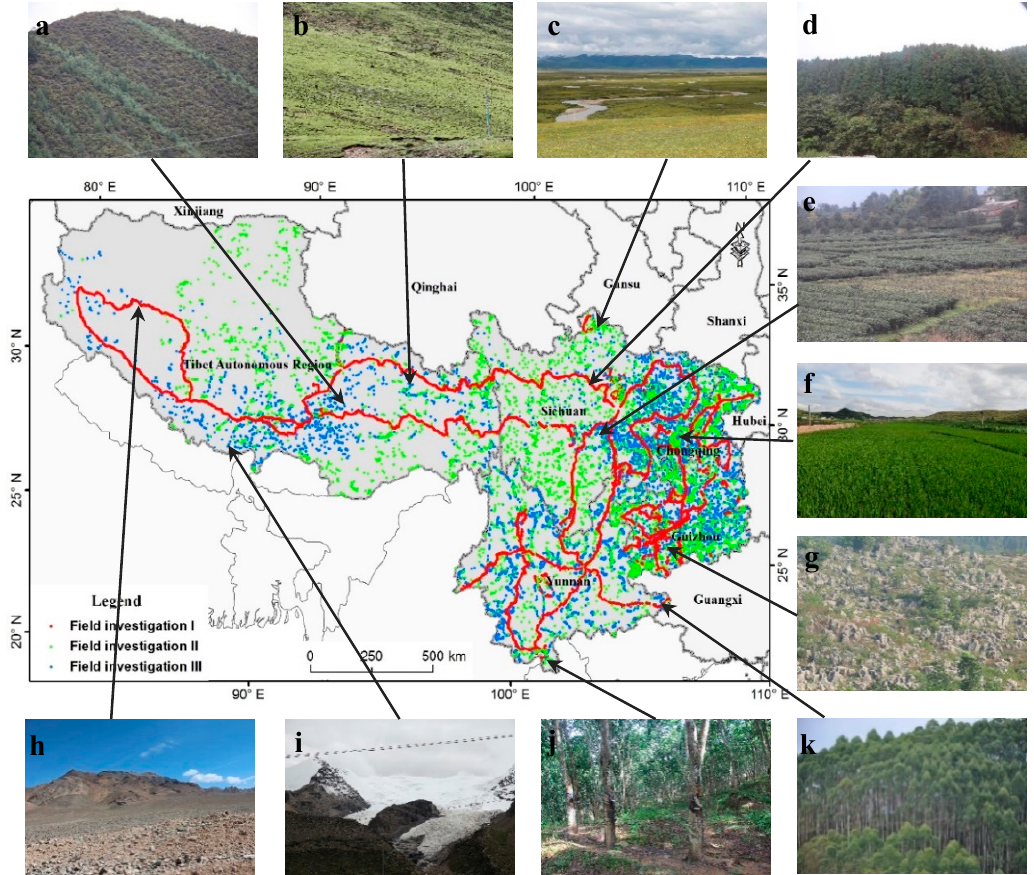
Figure 4. The spatial distribution of field samples used for generating the CLC-SW2010 product. The pictures ( a – k ) represent respectively the deciduous broadleaf shrubs, meadows, herbaceous wetlands, evergreen needleleaf forests, tea garden (shrub plantations), paddy fields, karst vegetation (herbosa), bare soils, permanent snow and ices, rubber plantations (woody plantations) and eucalyptus plantations (woody plantations).